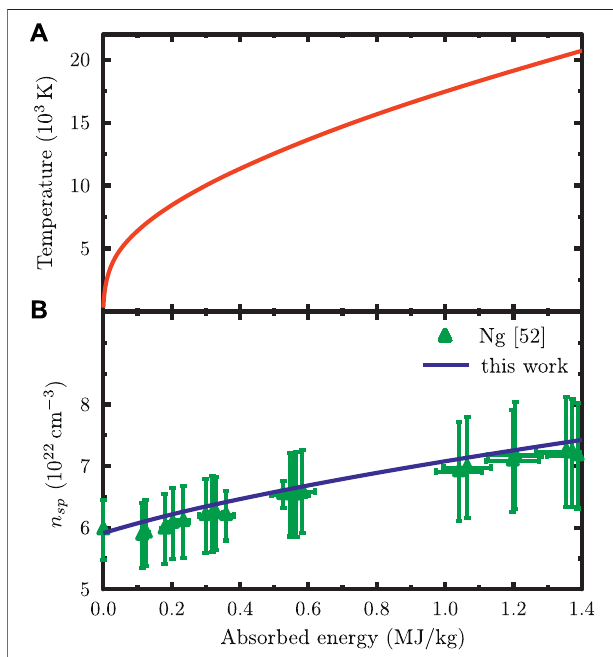
FIGURE 2 | Predictions of (A) the electron temperature and (B) the electron density in the 6 sp -conduction band of gold as a function of the absorbed energy. The conduction band density is compared with experimental data from Ref. [52].